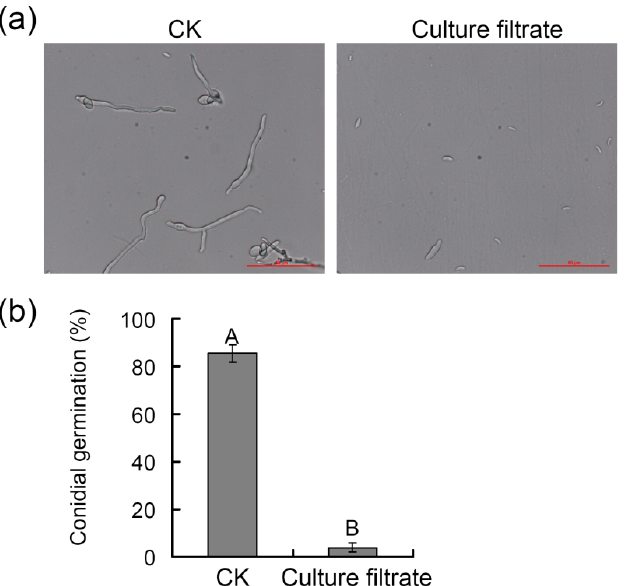
Figure 5. Effect of culture filtrate of ZZ1 on conidial germination of V. pyri . ( a ) Optical photomicrograph of conidial germination of V. pyri after treatment with culture filtrate of ZZ1 isolate. Bar, 50 μ m. The picture was taken at 36 h after inoculation ( b ) Inhibition of culture filtrate of ZZ1 on conidial germination of V. pyri . Conidial germination was counted at 36 h after inoculation. Values are means ± SD from three replicates. Letters above the bars indicate statistical significance ( p < 0.01) based on Tukey’s